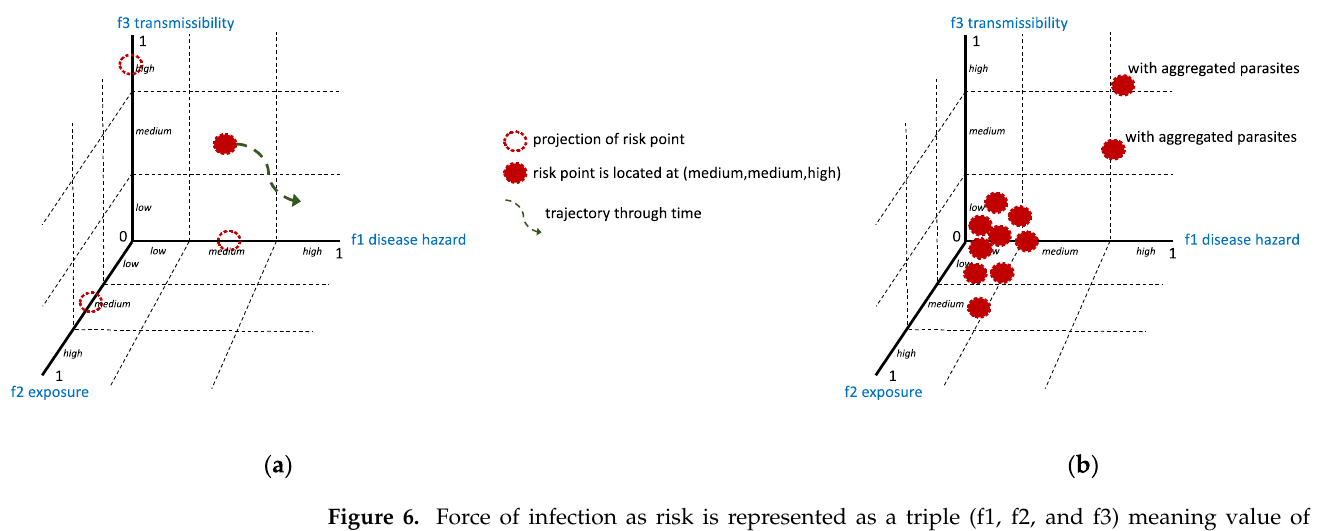
Figure 6. Force of infection as risk is represented as a triple (f1, f2, and f3) meaning value of disease hazard, value of exposure, and value of transmissibility. ( a ) example of a risk point, which characterizes status of one individual host for a specific time frame; ( b ) collection of risk points, which characterizes host population.